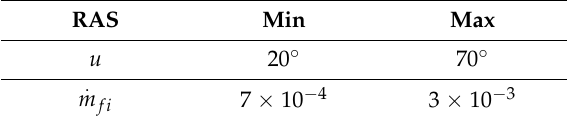
Table 1. Range of excitation signals for AFR modeling using RBFN. RAS: random amplitude signals.